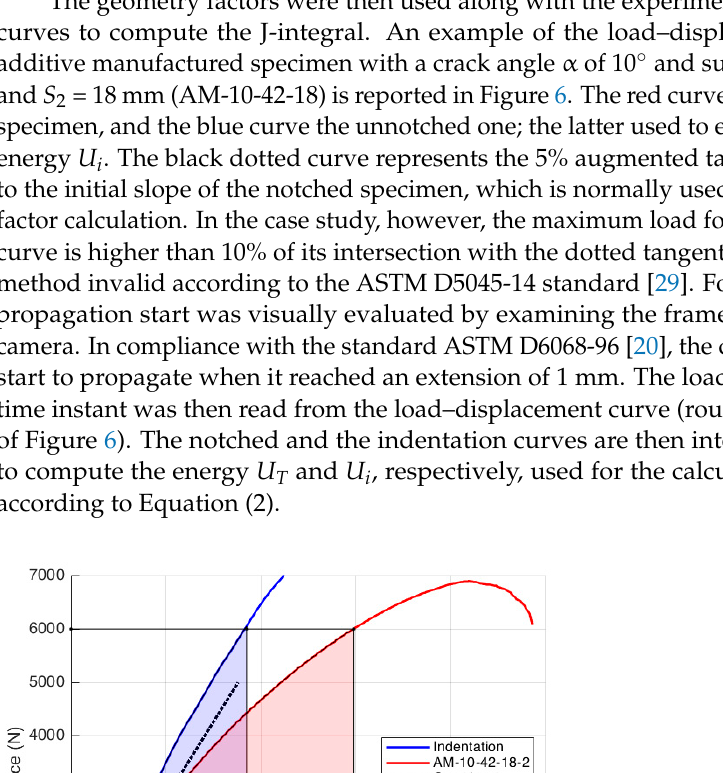
Figure 5. Geometry factor η as a function of the ratio S 2 /R for different crack angles α .